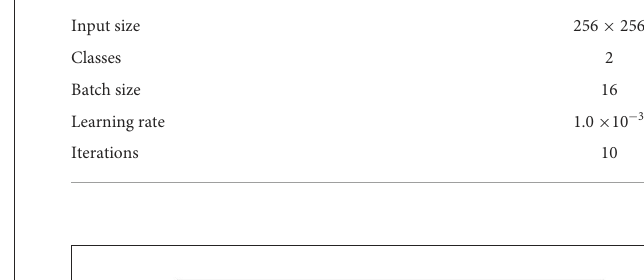
FIGURE7 The value of the sample entropy with different numbers M of IMFs.